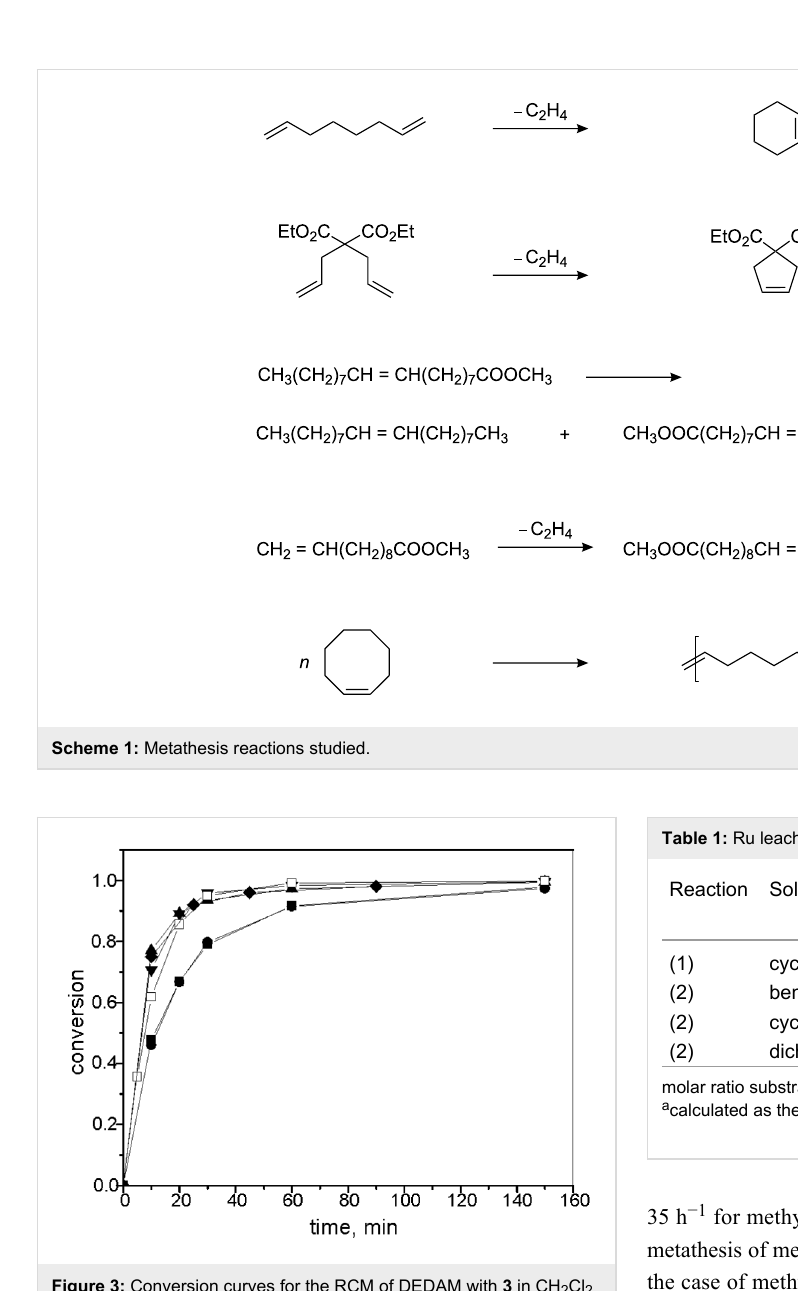
of substrate conversion in liquid phase after its separation from solid catalyst indicated that the Ru species released from the solid catalyst were capable of initiating catalytic reactions.